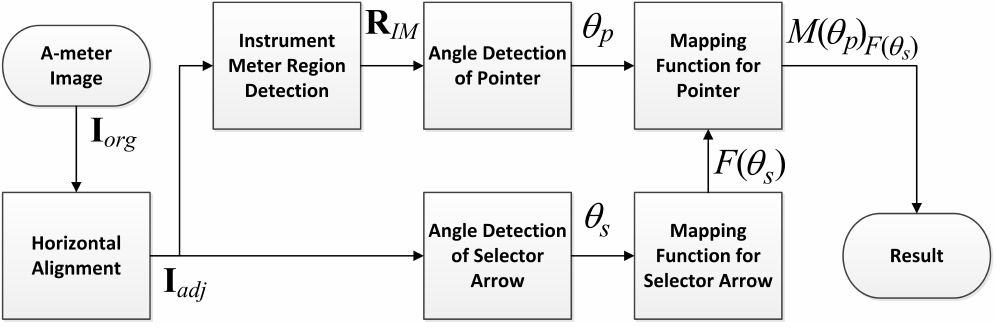
Figure 2. Flowchart of the proposed approach